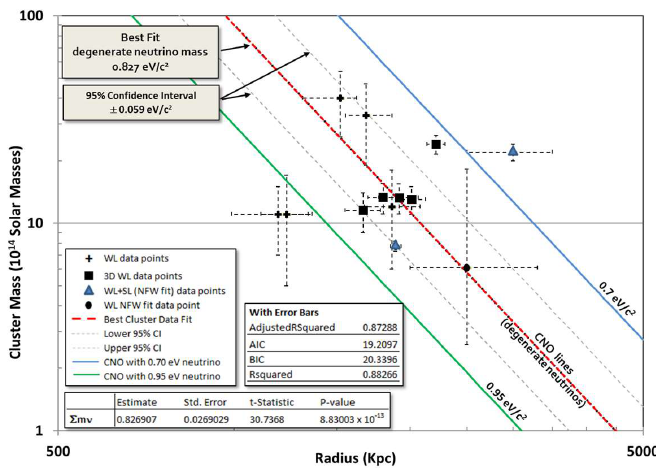
Figure 5. The log-log plotted virial mass and radii from identified weak lensing data with best fit to the data (0.827 eV/c 2 ) line and the 95% Confidence Interval lines of ± 0.059 eV/c 2 from the best fit line, respectively.